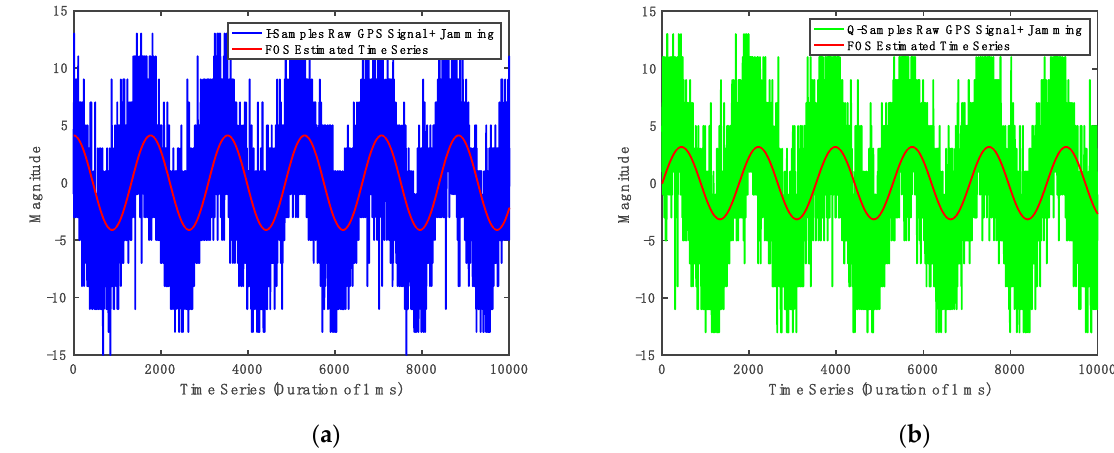
Figure 8 . FOS Estimated Jamming Signal. ( a ) In-phase (I) time-series signal; ( b ) quadrature (Q) time series signal.